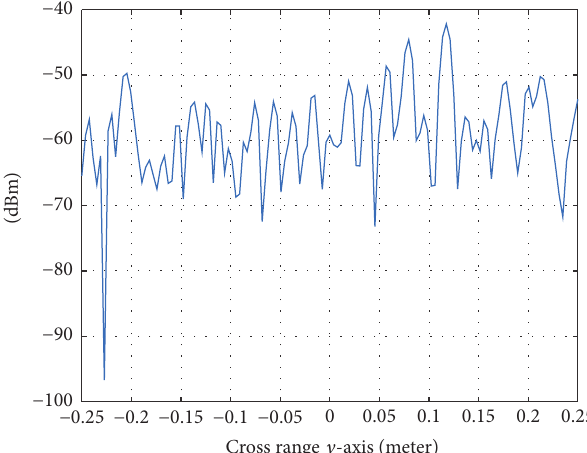
Figure 19: The sectional view of power density and sidelobe at 𝑦 - axis after applying CLEAN algorithm for irregular complex target shape geometry.